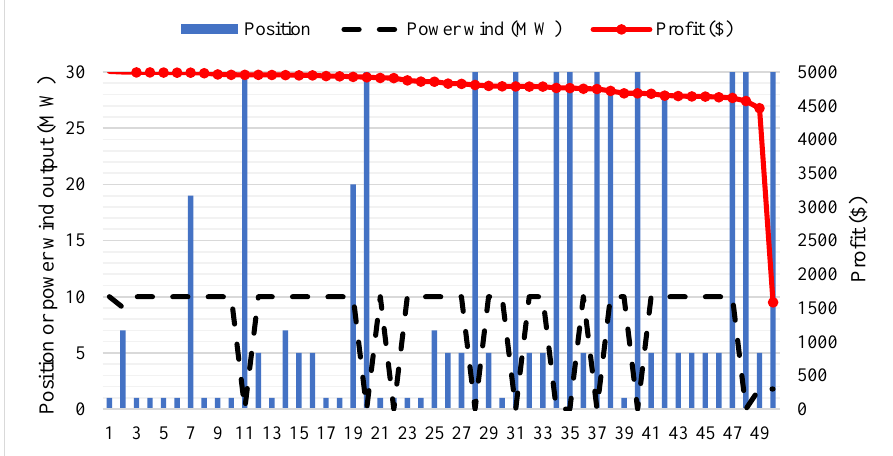
Figure 16. Optimal location and size of wind turbine obtained by GA for 50 runs.